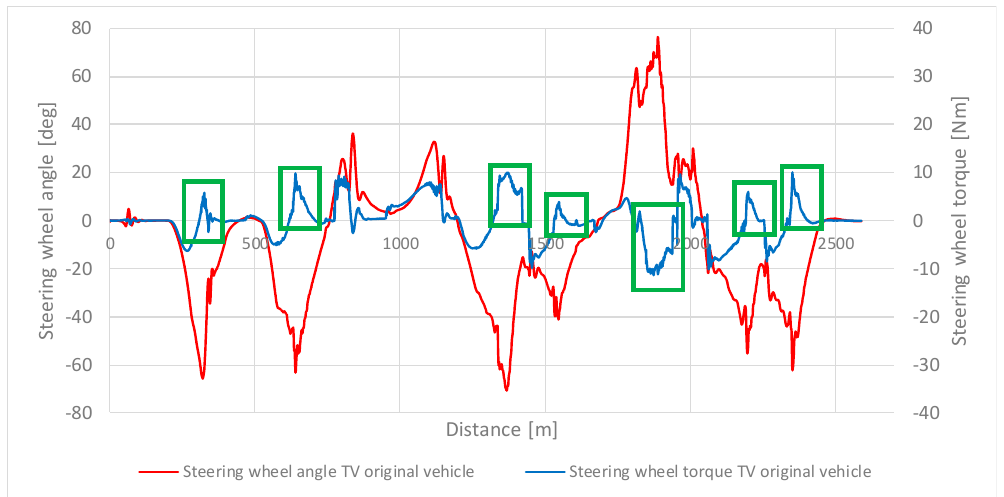
Figure 23. The original vehicle with TV: steering wheel angle (red) and steering wheel torque (blue). Self-steering moment showed in green boxes.